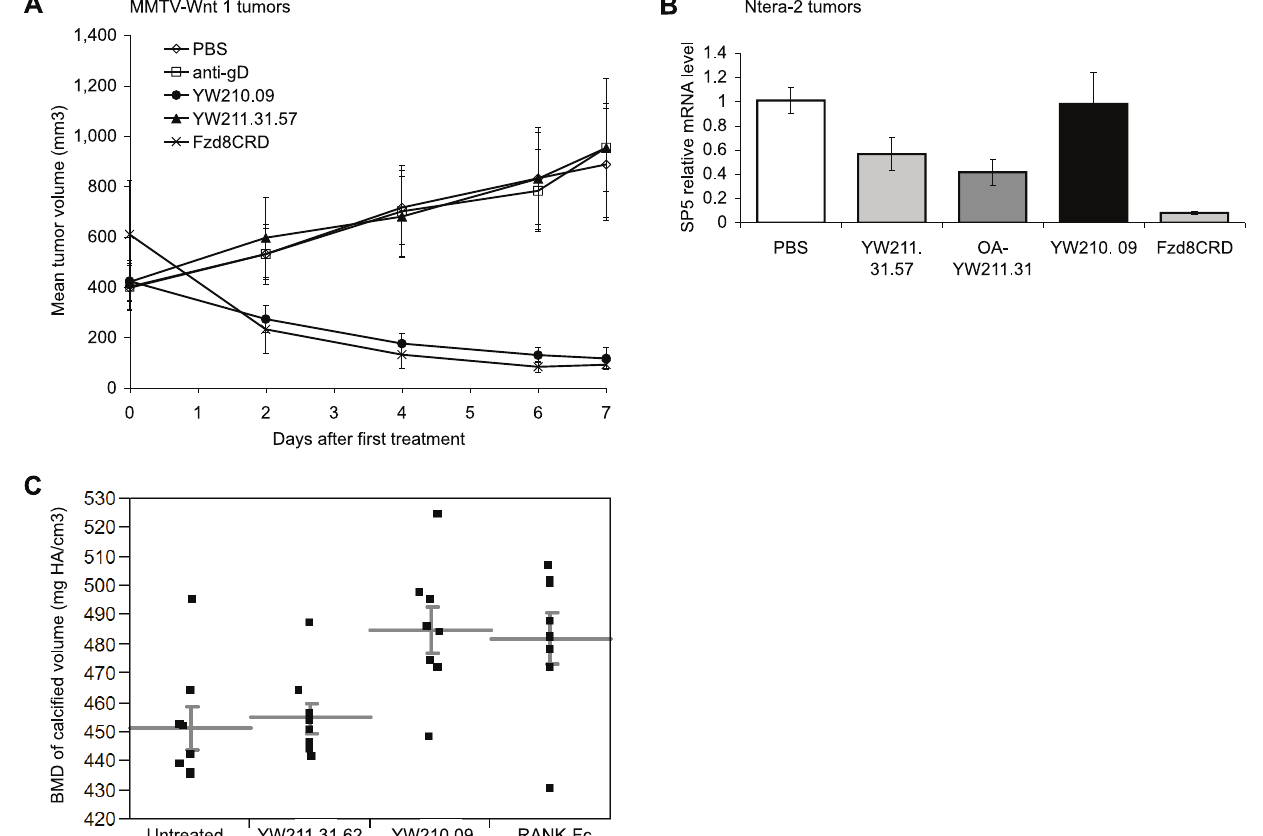
Figure 7. Wnt-driven signaling and growth in tumors, and mineral density in bone, are modulated by specific LRP6 antibodies. (A) MMTV-Wnt1 allograft tumors show regression of growth when mice are treated with YW210.09 antibody, similar to that observed with Fzd8CRD-Fc protein. YW211.31.57 antibody did not alter tumor growth under these conditions compared to control buffer (PBS) or anti-gD antibody treatment. Mice were administered 30 mg/kg of antibody or protein every two days (arrowheads). (B) Ntera-2 xenograft tumors display reduced expression of SP5 mRNA by qPCR analysis in mice treated with intact or one-armed (OA) YW211.31 antibody, but not with YW210.09 antibody. SP5 mRNA levels were normalized to GAPDH mRNA levels within the same tumor, and additionally normalized to PBS-treated tumors. All treatments except YW210.09 display p-value , 0.005 by ANOVA compared to PBS control. (C) YW210.09, but not YW211.31.62, antibody treatment of mouse calvaria explants in culture significantly increases bone mineral density (BMD) of calcified parietal bone, similar to treatment with RANK-Fc protein. All treatments were 10 m g/ml antibody or protein for 7 d. Data points represent eight calvaria halves from four mice for each treatment group; mean and standard error of the mean are shown as horizontal and vertical lines, respectively. Only YW210.09 and RANK-Fc treatments differ significantly from untreated samples with p-values less than 0.01 and 0.05, respectively, by Dunnett’s test ( , 0.05 for both by t-test).